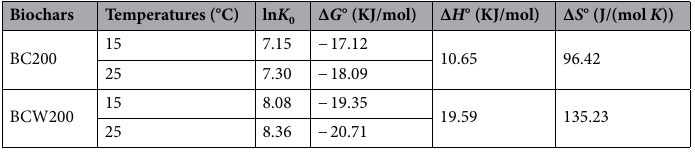
Table 5. The thermodynamic parameters of sorption of OFL by BC200 and